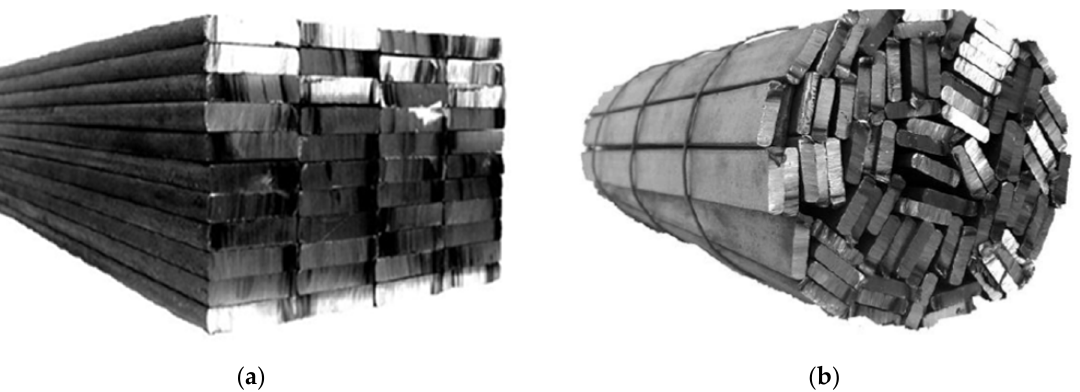
Figure 1. Bundles of flat steel bars: ( a ) a charge with an ordered arrangement; ( b ) a charge with a disordered arrangement.